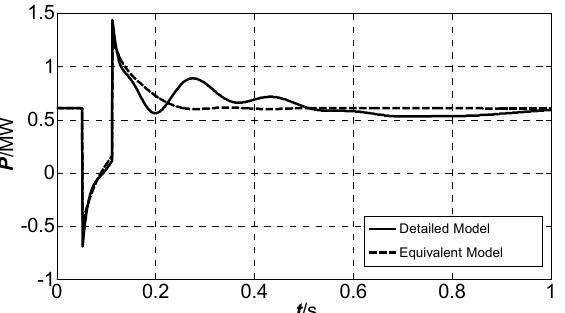
Figure 12. The active power dynamics of the detailed model and the equivalent model under condition B.